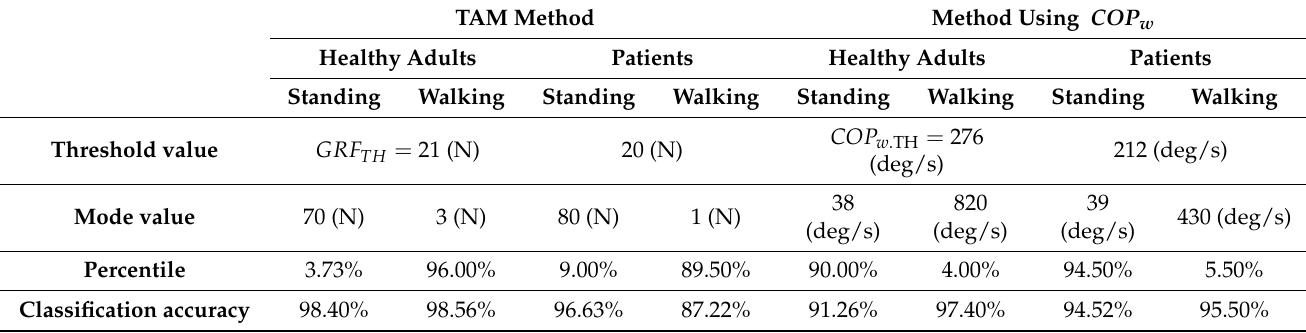
Table 2. Classification accuracies of the threshold methods: TAM—Timing Analysis Module, COP W —the waveform length . COP of